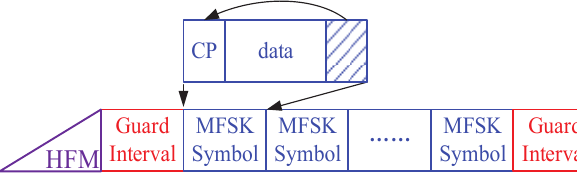
Figure 4. The data frame format of MFSK